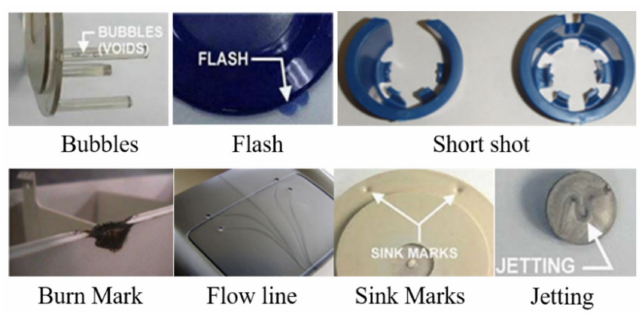
Figure 1. Primary defects of injection molded